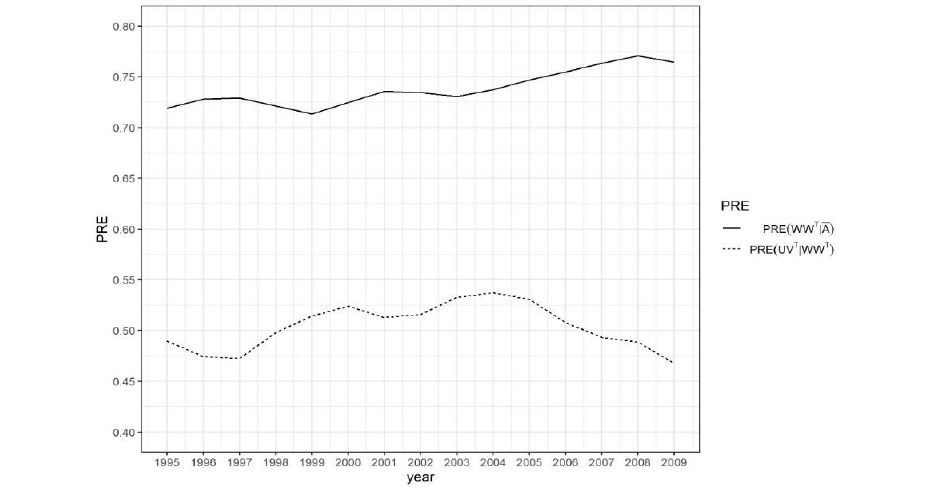
Figure 4. The evolution of the asymmetry of the international labor time flows, 1995–2009. 𝑷𝑹𝑬(𝑾𝑾 𝑻 |𝑨̅) measures how well the symmetric structure WW T fits the logged labor time flow network A . 𝑷𝑹𝑬(𝑼𝑽 𝑻 |𝑾𝑾 𝑻 ) measures the performance of the asymmetric structure UV T in accounting for the error that WW T fails to